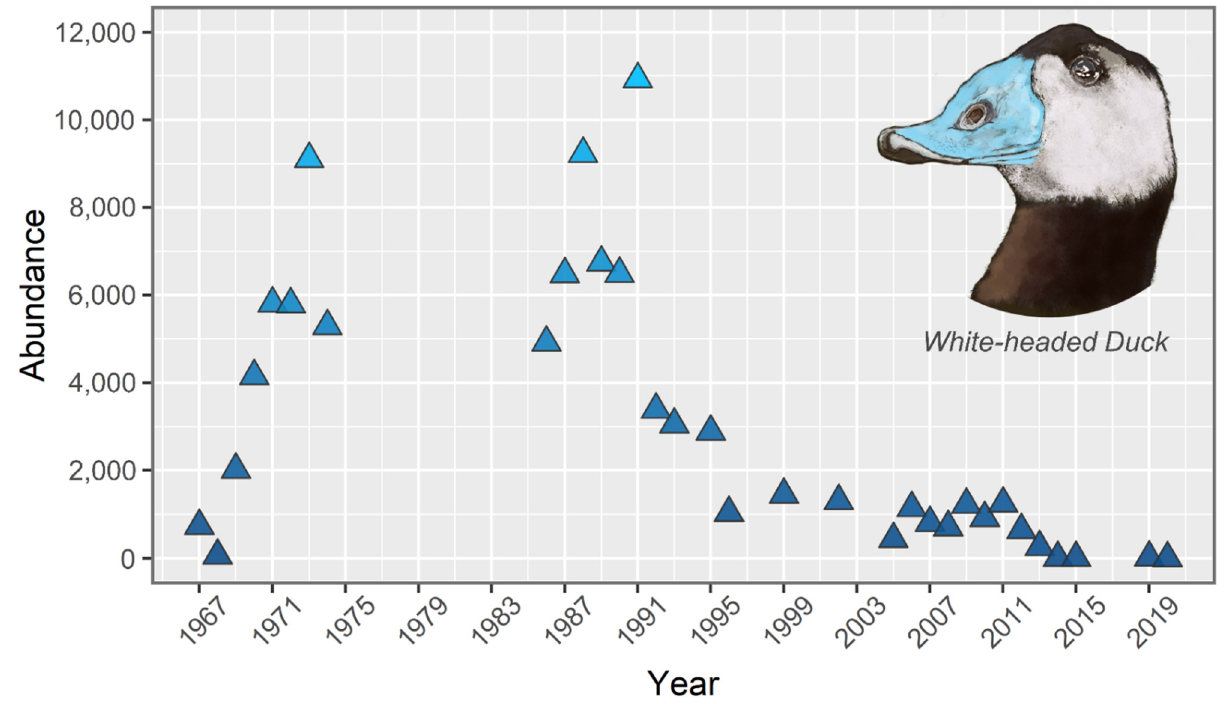
Figure 12. Wintering White-headed Duck abundance in the Burdur Basin from 1967 to 2020. Following the water level decline in the lake, wintering WHD numbers in the basin started to decrease dramatically. In 2019, there were only 18 wintering WHDs left in the lake and its basin, and none in 2020 [43]. Multiple factors seem to have contributed to this decline. First, when the lake started to shrink, the northern and shallowest part of the lake dried out [14]. This part was particularly important for waterbirds, including the WHD [83]. The remaining southern parts of the lake have a steeper morphometry and offer limited amounts of shallow areas for waterbirds [14]. The loss of the shallow areas seems to have been the biggest contributor to the decline of the WHD population, considering that most WHDs were found there earlier [81]. Water level declines in the other lakes in the basin may also have contributed to the regional decline of the wintering population. Secondly, the loss of the shallow areas and increasing salinity may have decreased the capacity of the lake to support chironomids, which are the main food sources of WHDs [80]. Chironomid abundance in the lake was found to increase steadily up to and peak at around 10 m and decreased steeply at higher depths [85]. Studies have shown that high salinity levels can decrease the growth rate, survival, size, and emergence rate of some chironomid species [86,87] as well. Taxonomic studies have also confirmed an overall decrease in the diversity of benthic macroinvertebrates, including chironomids, between the late 1980s and mid-2000s [88]. Furthermore, the once-high hunting pressure in Lake Burdur may have contributed to the decline of the WHD population. Even when the lake was declared a no-hunting zone, around 4.5 WHDs per day were estimated to have been shot in only one-quarter of the lake, which was well over the sustainable limit [81]. In the winter of 1992–1993 alone, at least 1000 WHDs were estimated to have been shot [89]. Finally, declines in the regional and national breeding populations [82] likely also contributed to the decline, showing the effects of multiple stressors in addition to the water loss